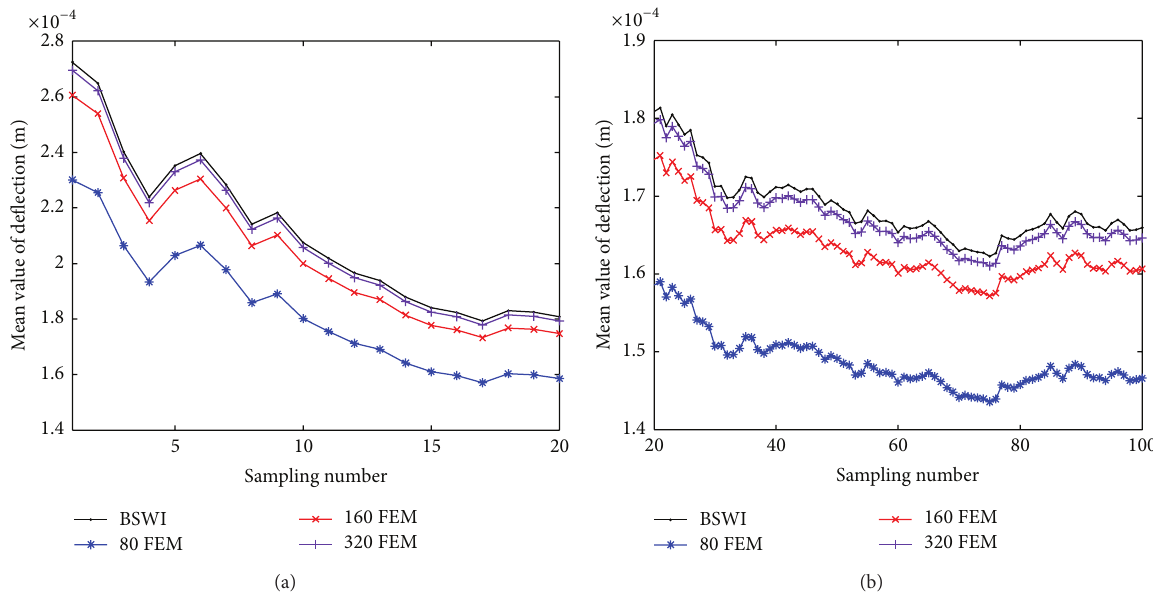
Figure 7: Relationship between the mean value of beam center deflection and sampling number: (a) sampling number 1–20 and (b) sampling number